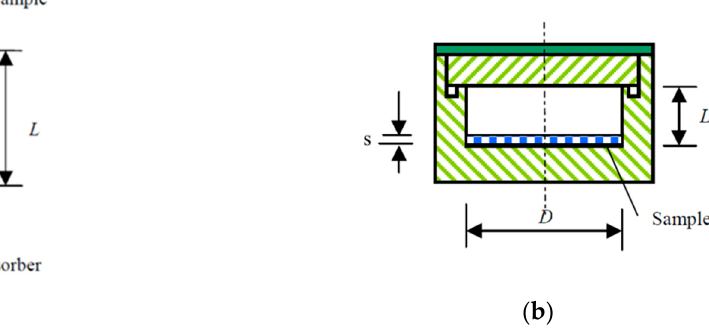
Figure 3. Representations of resonator R A ( a ) and R B ( b ) for the analytical approach when s d ~ D A , D B .